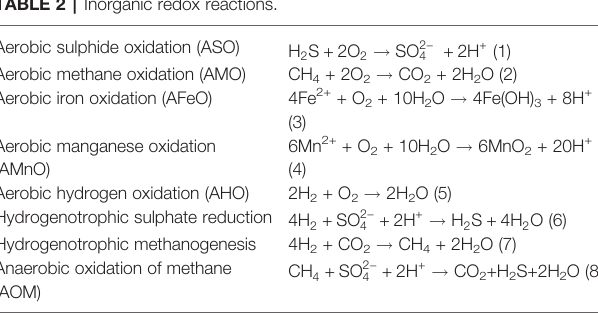
TABLE 2 | Inorganic redox reactions. Aerobic sulphide oxidation